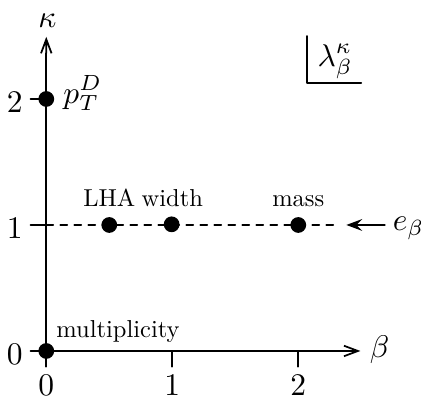
Figure 2. Two-parameter family of generalized angularities, adapted from ref. [14]. The dots correspond to the (cid:12)ve benchmark angularities used in this study, with \LHA" referring to the Les Houches Angularity. The horizontal line at (cid:20) = 1 corresponds to the IRC-safe angularities, e (cid:12) = (cid:21) 1 where i runs over the jet constituents, z i is a (normalized) angle to the jet axis. The parameters (cid:20)